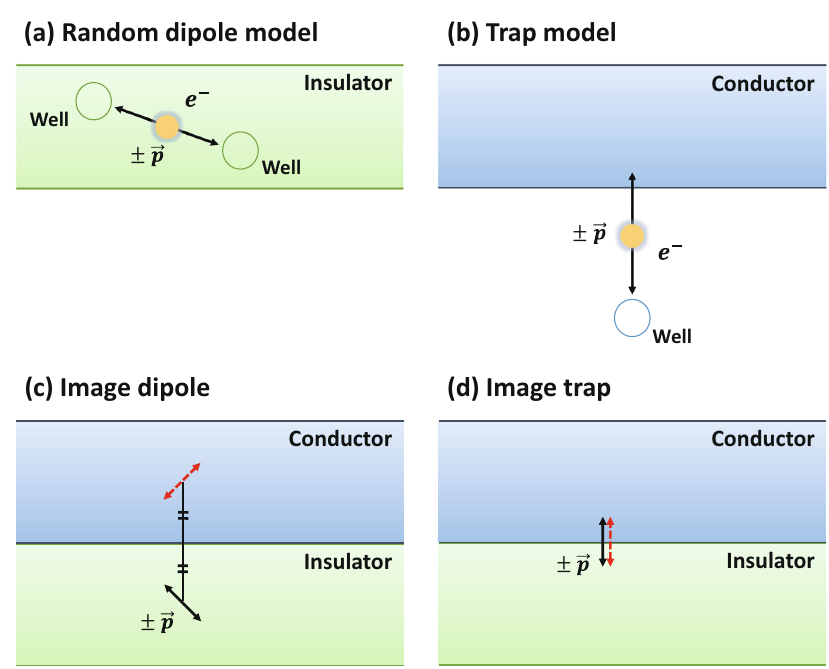
Fig. 1 Conceptual diagram of random dipole model and trap model. a and b A charge moves back and forth between bistable potential wells in the random dipole model while between the Fermi surface of a conductor and a trap of an insulator in the trap model. The screening effect of metallic gates can be taken into account by adding image charges to the conductor. c and d Resultant image dipole and image trap are depicted as red dashed arrows